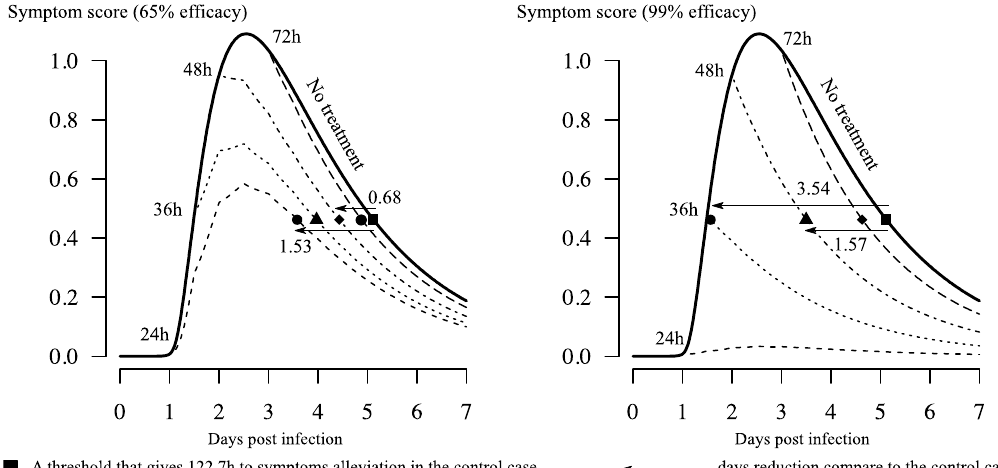
Figure 4. Illustration of the treatment effect on symptom score dynamics. Different shapes were used to indicate the time to first alleviation of symptoms of corresponding dynamics. The simulated treatment is 75 mg of oseltamivir taken twice daily, starting at different times post-infection; the solid line is the case without treatment. The value 122.7 h is the median of time to symptom alleviation reported in clinical trials [5]. The symptom score dynamics of the control case was taken from a previous model fitted to human volunteer data